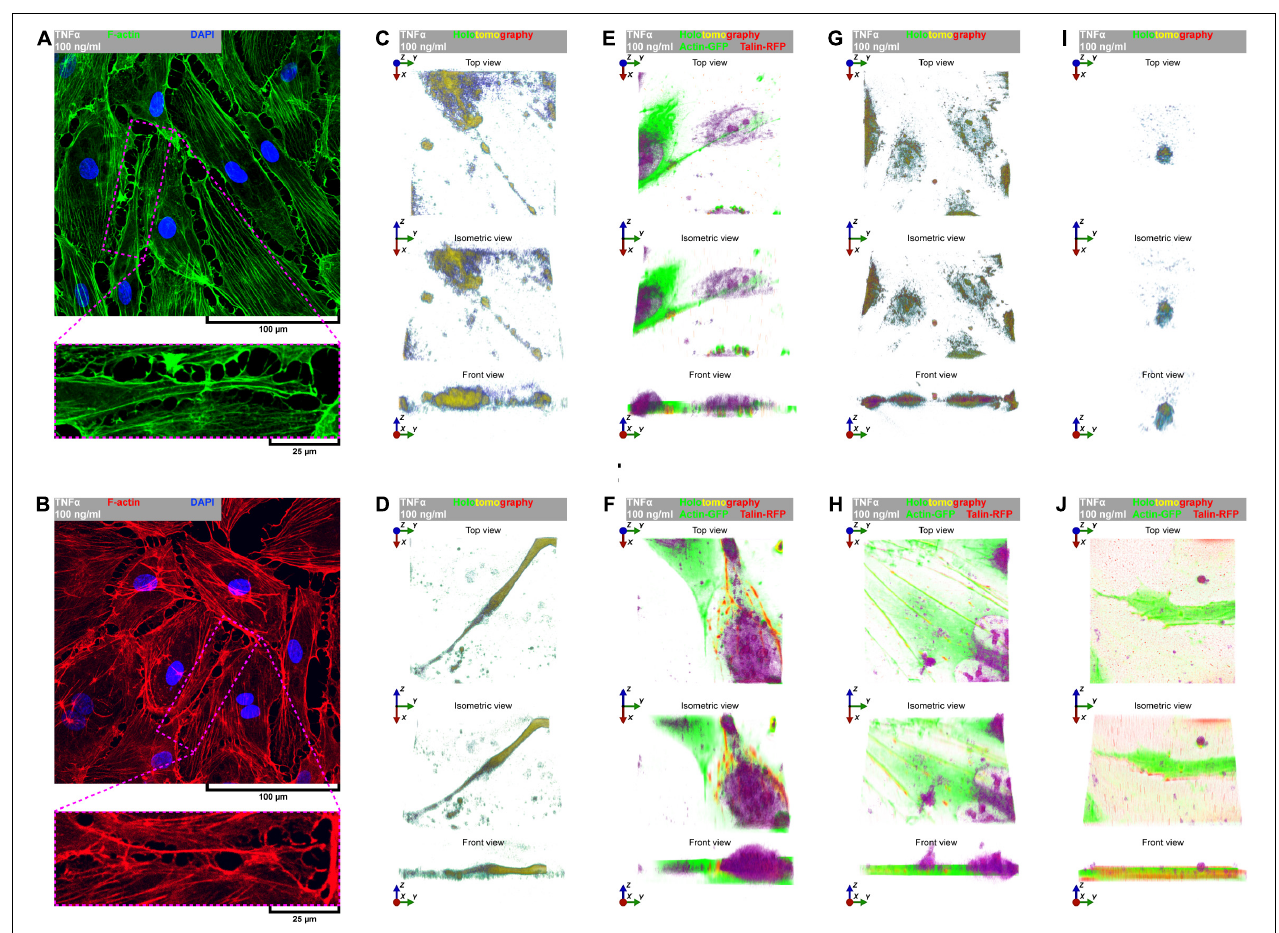
FIGURE 5 | TNF α -induced formation of migrasomes and migracytosis. (A) Representative confocal micrograph of fluorescently stained F-actin. Double fluorescent staining for F-actin (green) and DNA (blue) was performed after fixation. TNF α 100 ng/ml to cells treated with rh TNF α . (B) Representative confocal micrograph of fluorescently stained F-actin. Double fluorescent staining for F-actin (red) and DNA (blue) was performed after fixation. TNF α 100 ng/ml to cells treated with rh TNF α . (C,D,G,I) Representative intravital holotomography micrographs of pHCAECs forming and releasing migrasomes. TNF α 100 ng/ml to cells treated with rh TNF α . (E,F,H,J) Representative intravital correlative holotomographic and fluorescence micrographs of pHCAECs forming and releasing migrasomes. Actin-GFP (red) and talin-RFP (green) were expressed using baculoviruses. TNF α 100 ng/ml to cells treated with rh TNF α